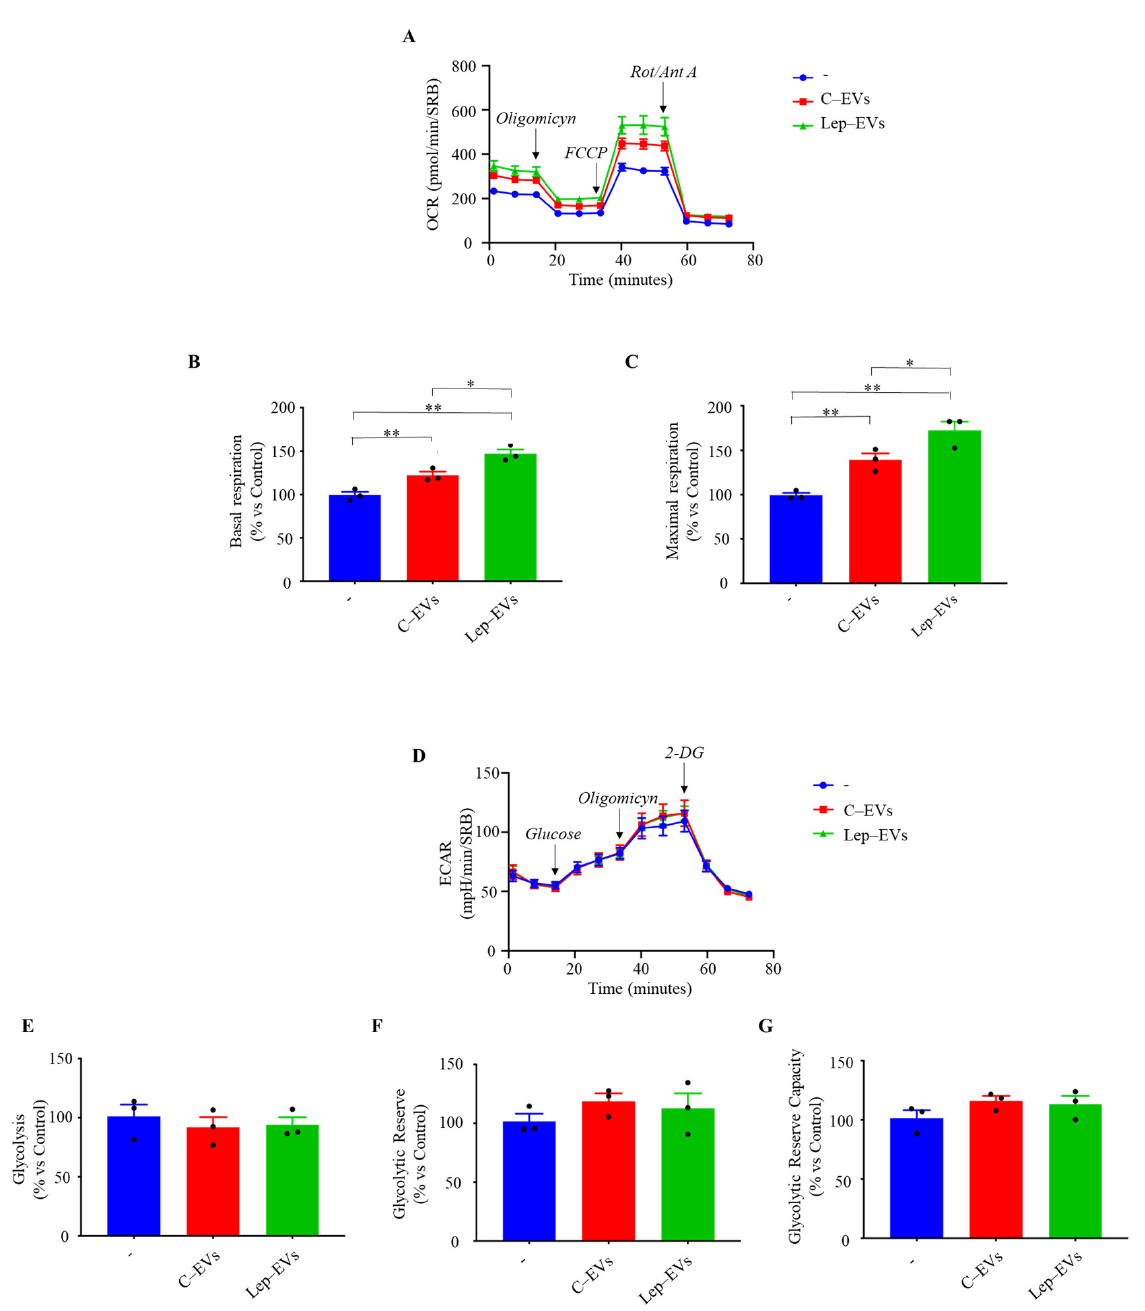
Figure 5. Lep-EVs sustain mitochondrial metabolism of MCF-7 breast cancer cells. The mitochondrial and glycolytic metabolic profile of MCF-7 cells untreated (–) or treated with C-EVs and Lep-EVs (2 µ g/mL) for 48 h were assessed using the Seahorse XF-e96 analyzer. Schematic tracing of OCR flux ( A ) and relative histograms of different mitochondrial respiration parameters such as basal ( B ) and maximal ( C ) respiration were reported. ( D ) ECAR representative tracing and relative histograms of glycolysis ( E ), glycolytic reserve ( F ), and glycolytic reserve capacity ( G ) were reported. Each circle represents one independent experiment. Data represent the mean ± SEM of five biological replicates of three independent experiments and normalized by protein content (SRB assay). * p ≤ 0.05; ** p ≤